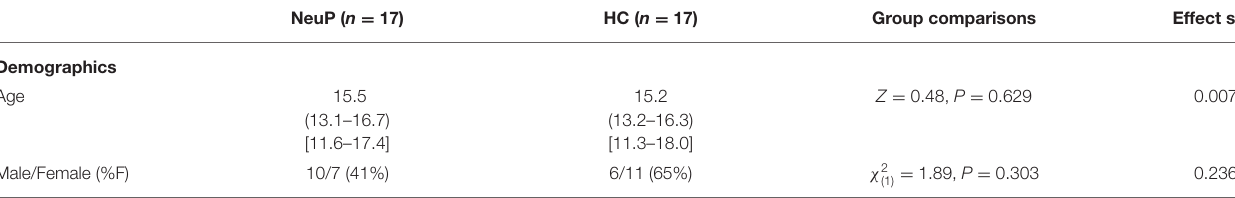
TABLE 2 | Comparative demographic data for patients and control